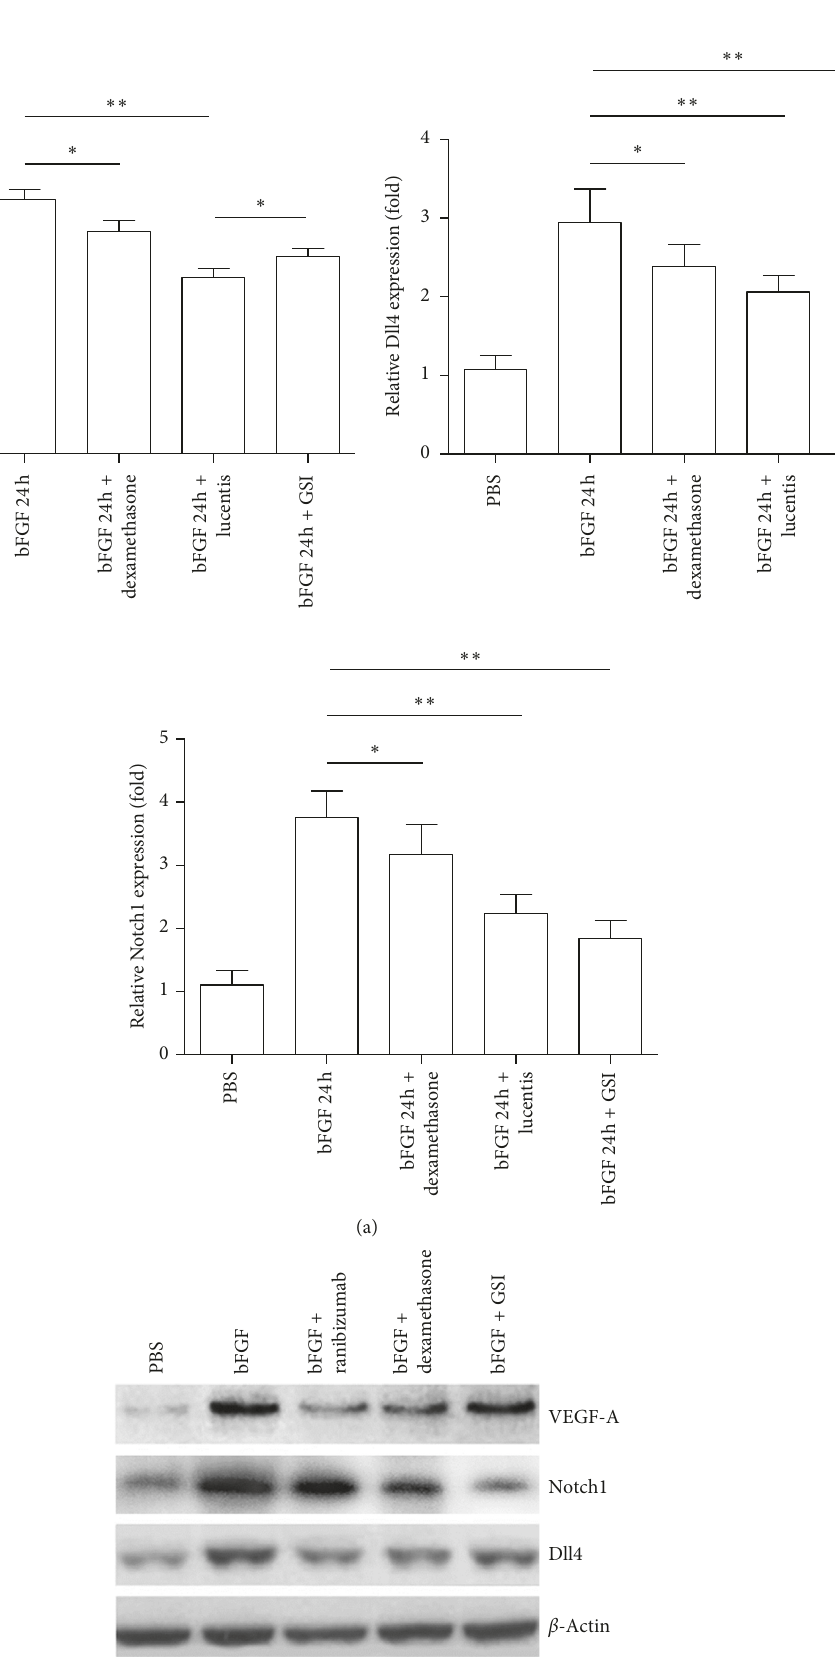
Figure 5: (a) VEGF-A, Notch1, and Dll4 mRNA expression. GSI inhibited the expression of Notch1 and Dll4 mRNA and promoted the Abs-conjugated MS in corneal vessels of treated, untreated, and bFGF-implanted eyes (day 7; n � 5). ∗ P < 0 . 05; ∗∗ P < 0 . 01. (b) Western blot analysis of VEGF-A, Notch1, and Dll4 protein